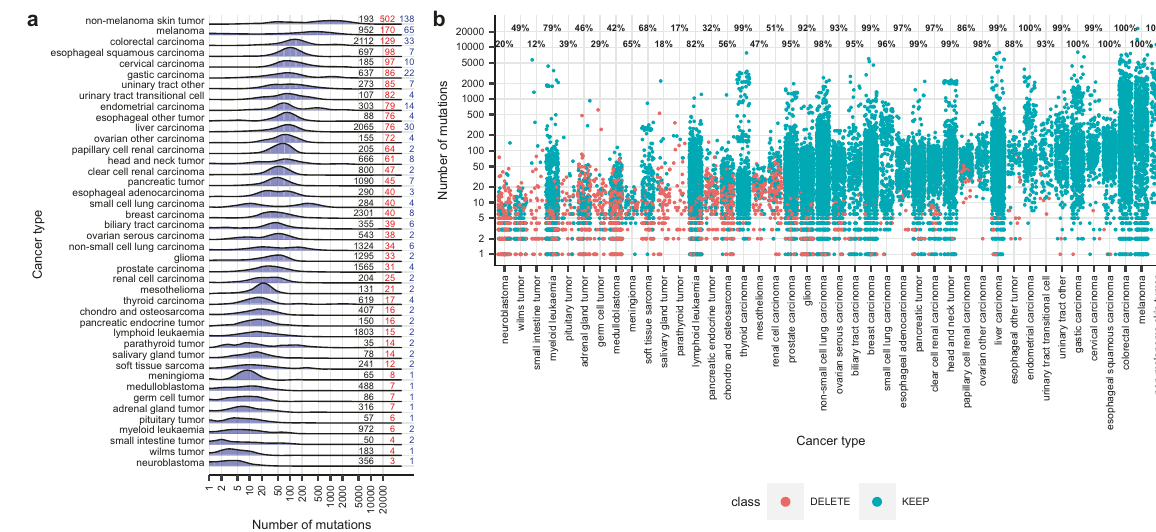
Fig. 1 Mutations in the tumor samples of COSMIC v84 (training dataset). a Distribution of TMBs across 42 cancer types in the 24,726 samples of the training dataset. The “ Y ” axis corresponds to the frequency of mutant samples. Numbers on the right of the plot indicate: black, number of samples included in the analysis; red, median TMBs; blue, median of common mutant genes. Cancer types are ordered by median TMBs. b Number of mutations in the individual tumor samples of COSMIC v84. Each dot represents a sample. In blue, samples conserved for the development of panels for TMB prediction, in red samples discarded. Numbers on top of each cancer type are the percentage of conserved